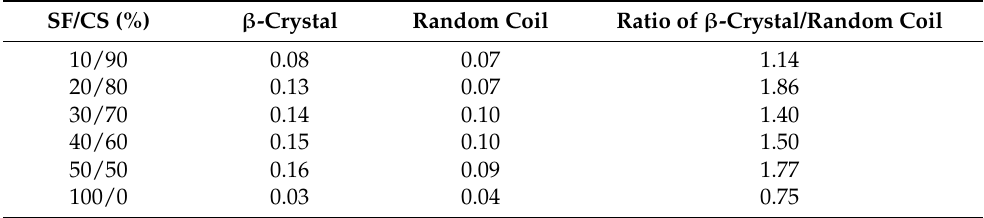
Table 2. Estimation of ratio of β -crystal/random coil at various SF/CS ratios. SF/CS (%) β